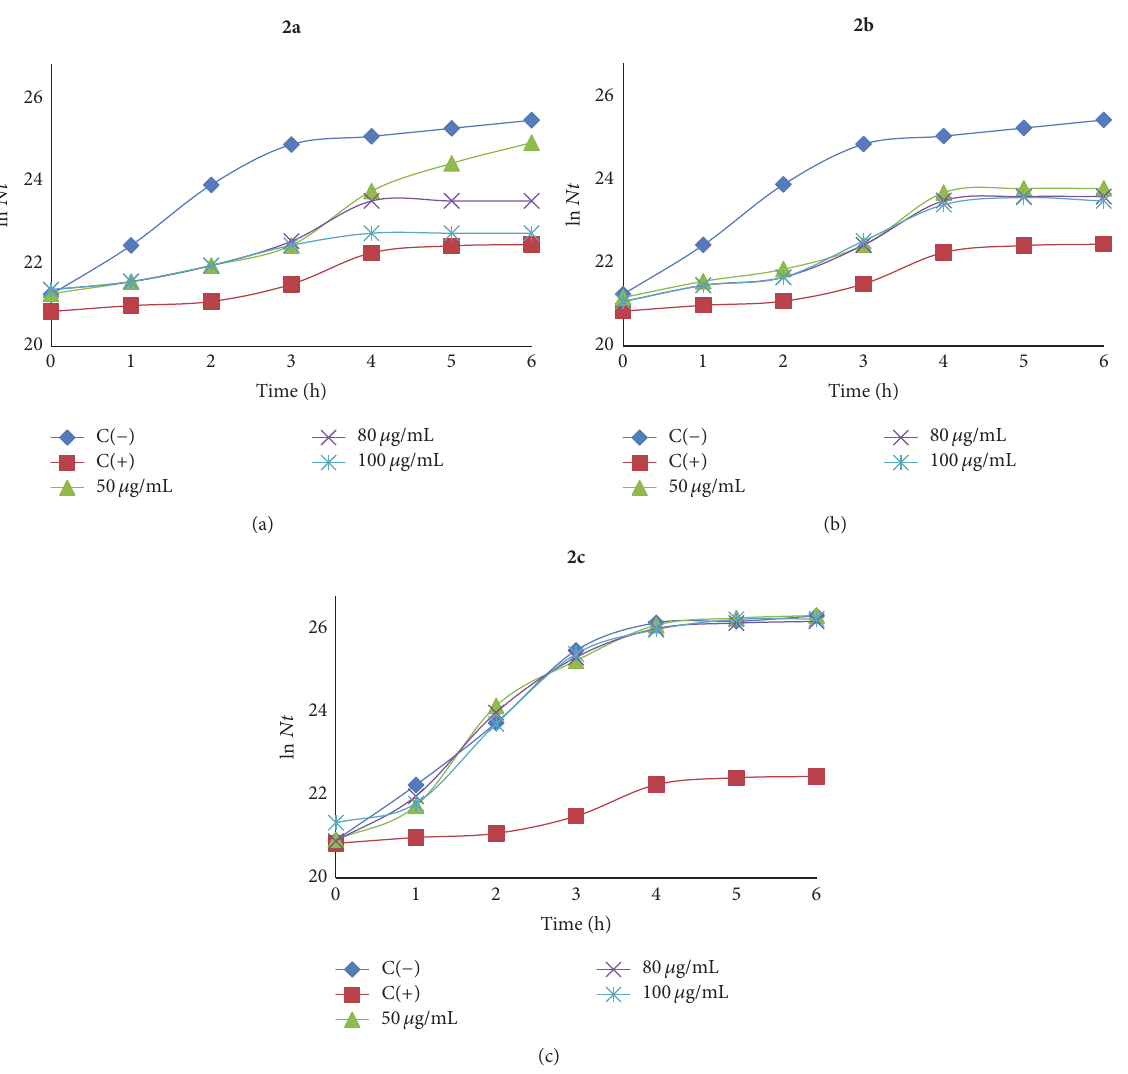
Figure 1: Growth of E. coli in media containing compounds: (a) 2a , (b) 2b , and (c) 2c